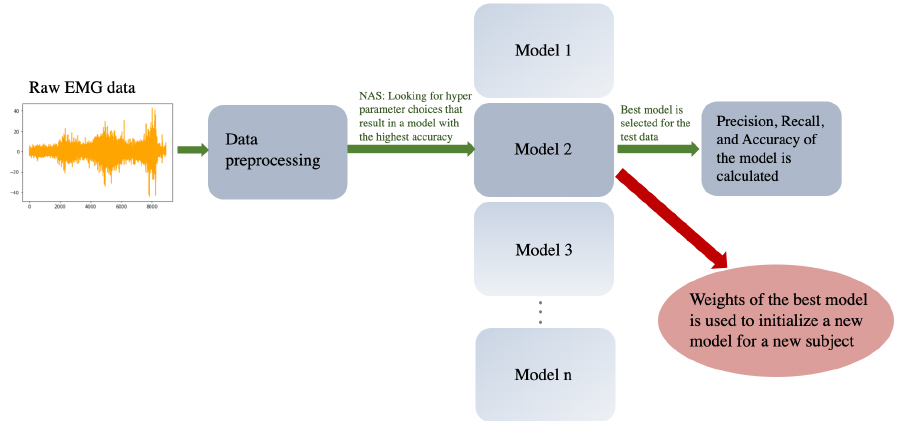
Figure 1. Flow chart of all major steps required from pre-processing the raw data to evaluating the